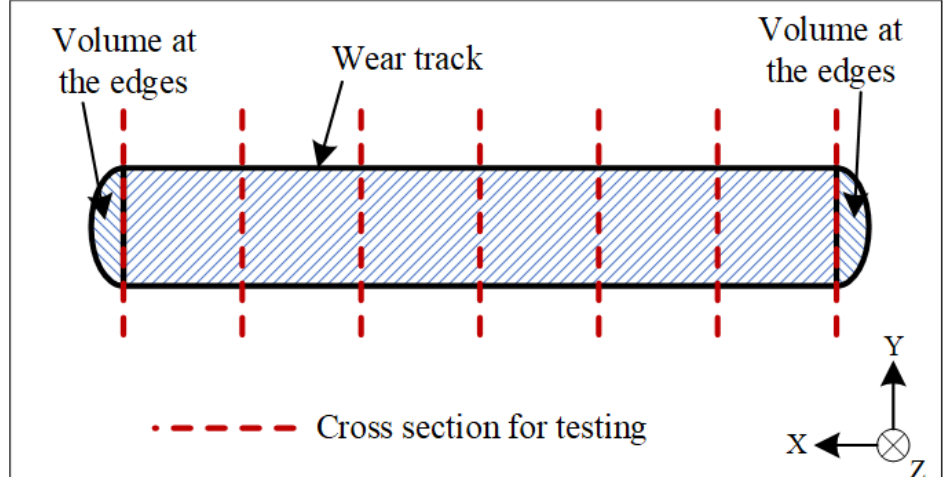
Figure 2. Schematic diagram of the wear scar used to calculate volume loss.